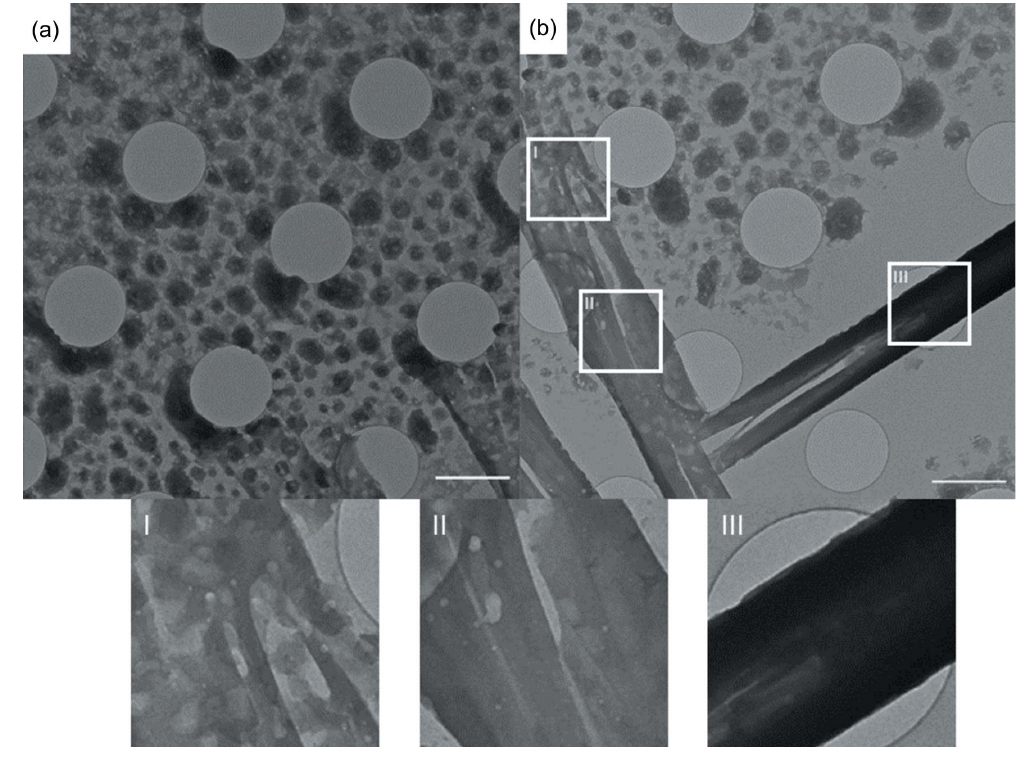
Figure 4 Images taken at room temperature after crystallization for 20 s and no vitrification. ( a ) Droplet-like features with roughened edges after removal of their surrounding mother liquor by the vacuum in the TEM. ( b ) Coalescence of the droplet structures producing two crystals of CBZDH, identified from morphology. White boxes labelled I, II and III show magnified areas within the sample. Scale bars = 2 m